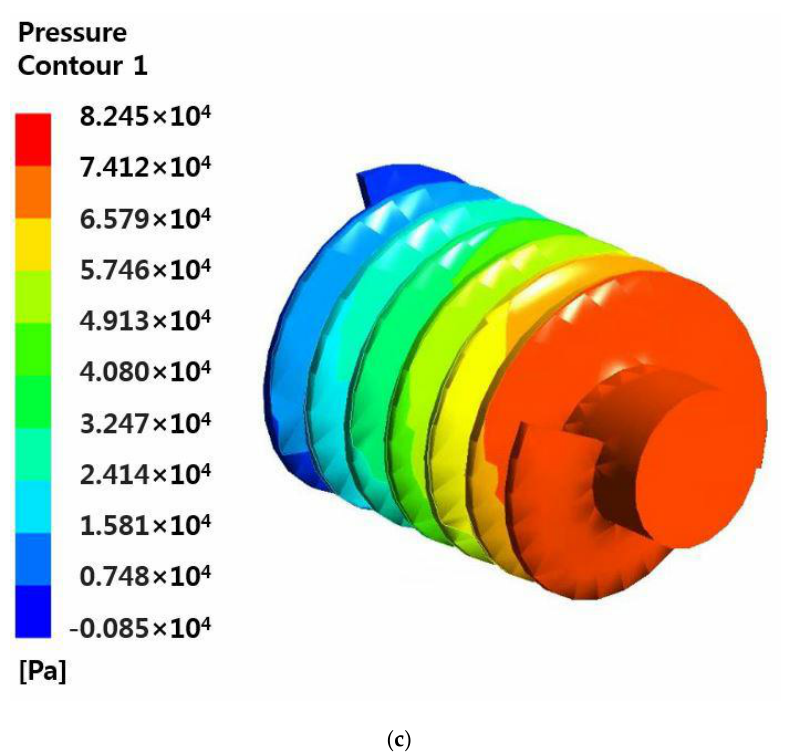
Figure 12. Pressure on the blade: ( a ) ω = 0 rad / s; ( b ) ω = 14 rad / s; ( c ) ω = 28 rad / s.